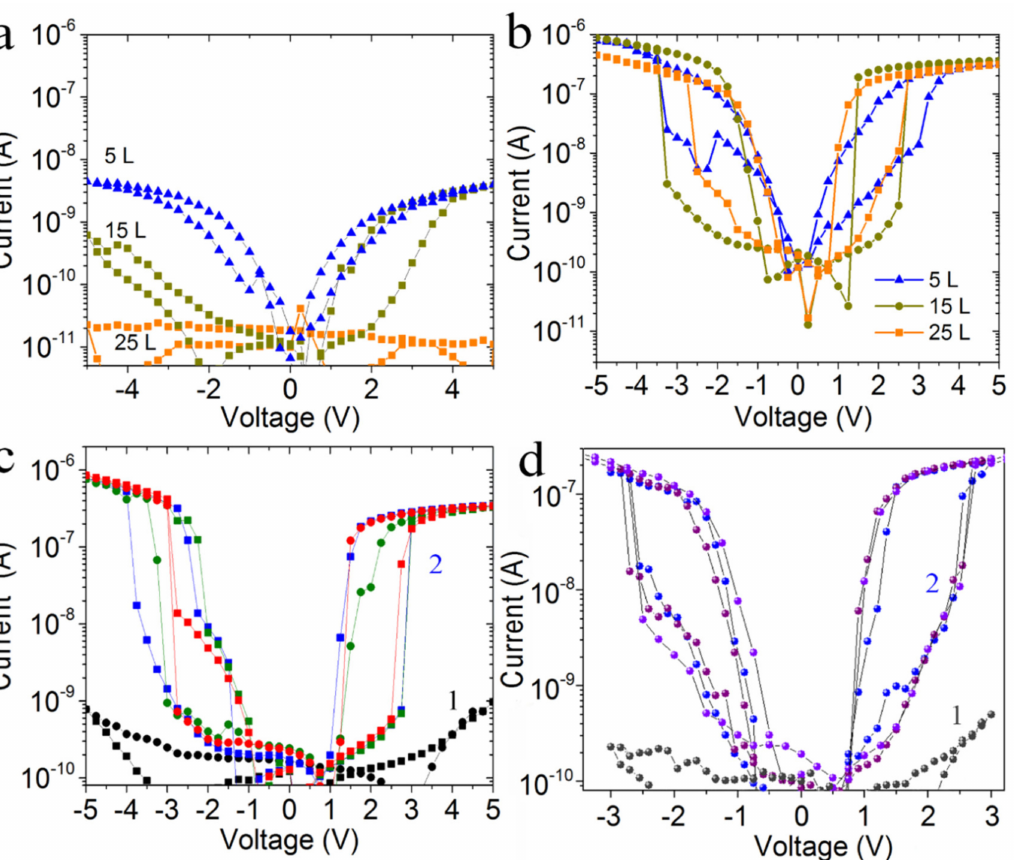
Figure 5. Current-voltage characteristics for the printed Ag–FG–PVA–Si crossbar structures with different thicknesses (5 L corresponds to 4 nm, 15 L to 13 nm, and 25 L to 20 nm) measured before and after the irradiation by Xe ions with the fluence of 3 × 10 11 cm − 2 . ( a , b ) I–V curves before ( a ) and after ( b ) the irradiation by ions with energy 26 MeV and the fluence 3 × 10 11 cm − 2 . ( c , d ) I–V curves measured before (1) and after (2) the irradiation: ( c ) FG thickness is 15 L (12 nm) and Xe ions with the energy of 26 MeV, ( d ) FG thickness is 25 L (20 nm) and Xe ions with the energy of 167 MeV. The contact area is 300 × 300 µ m 2